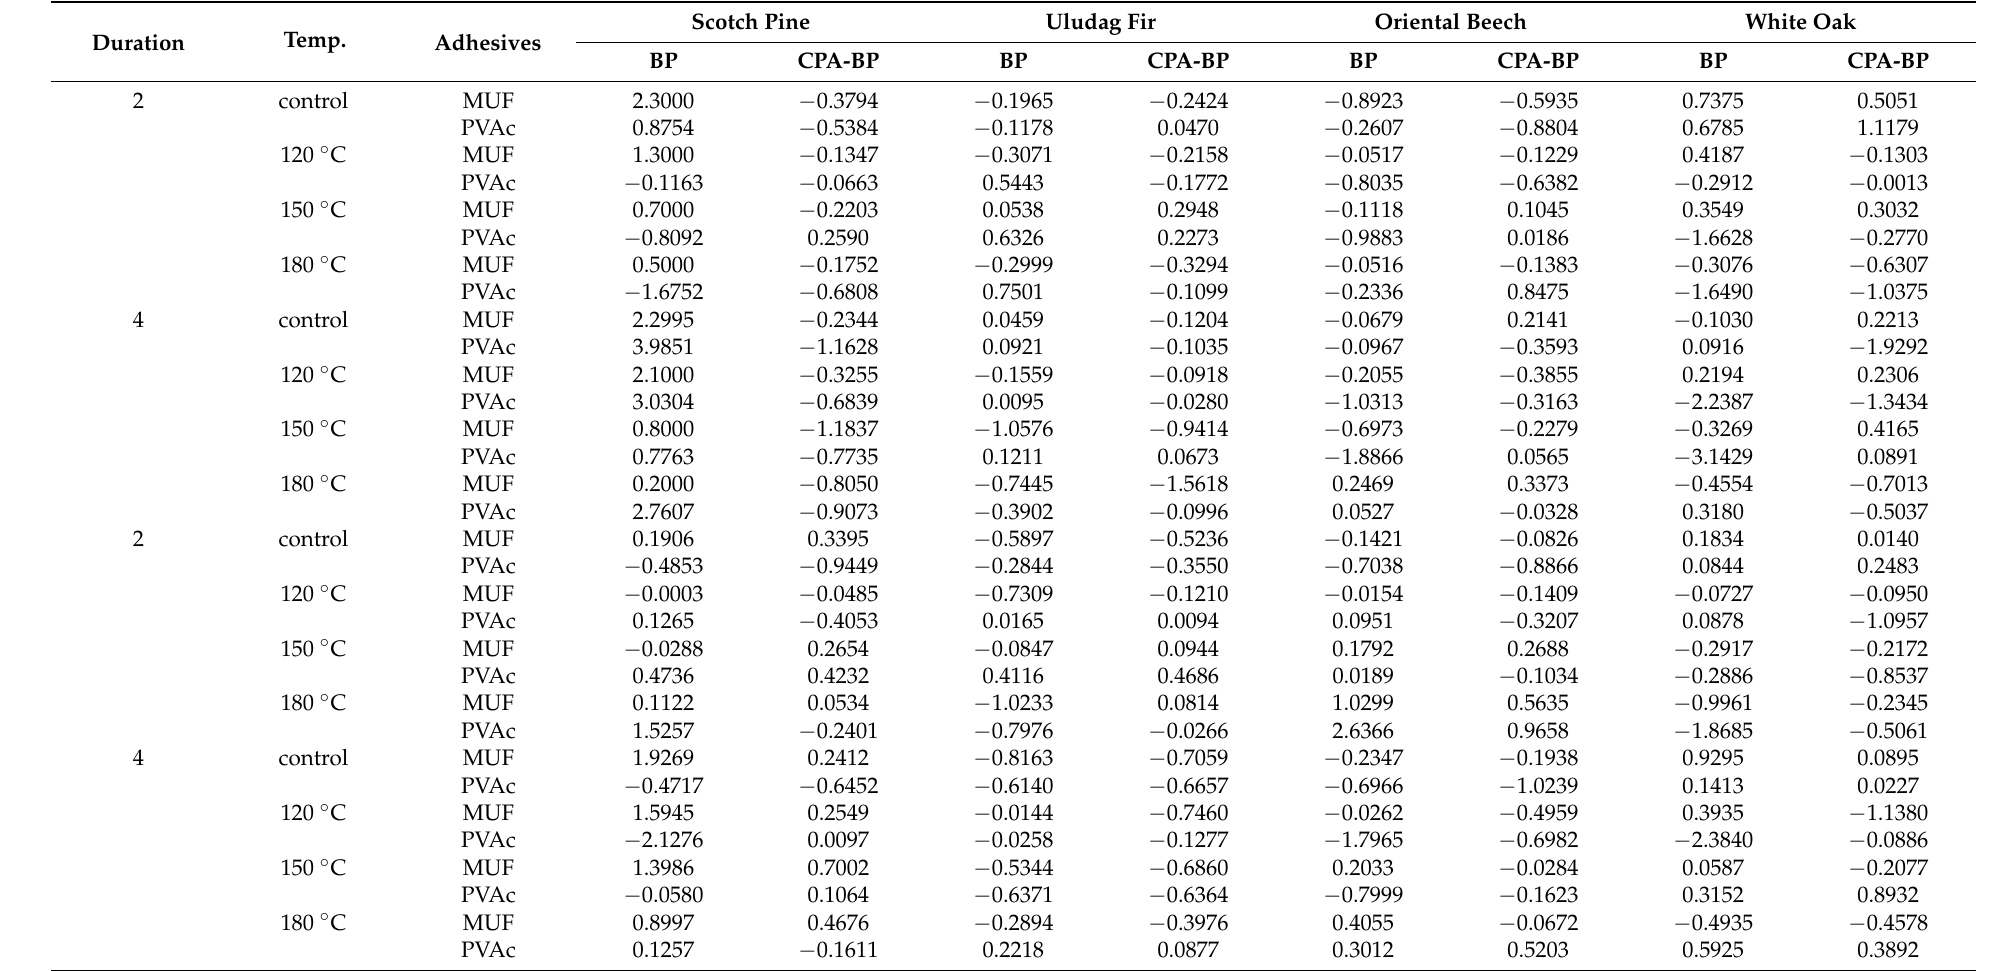
Table 8. ERROR comparison (bonding